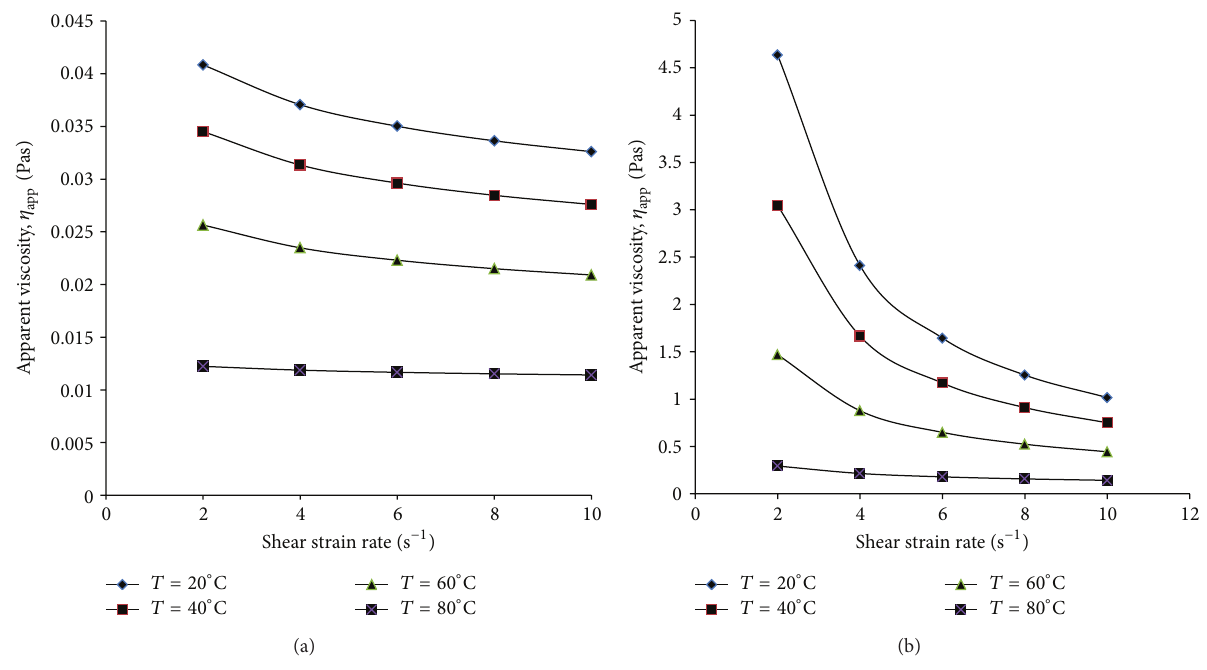
Figure 7: Apparent viscosity, 𝜂 , Pas versus shear strain rate for (a) 𝐸 = 0 kV/mm and (b) 𝐸 = 2.5 kV/mm for different app